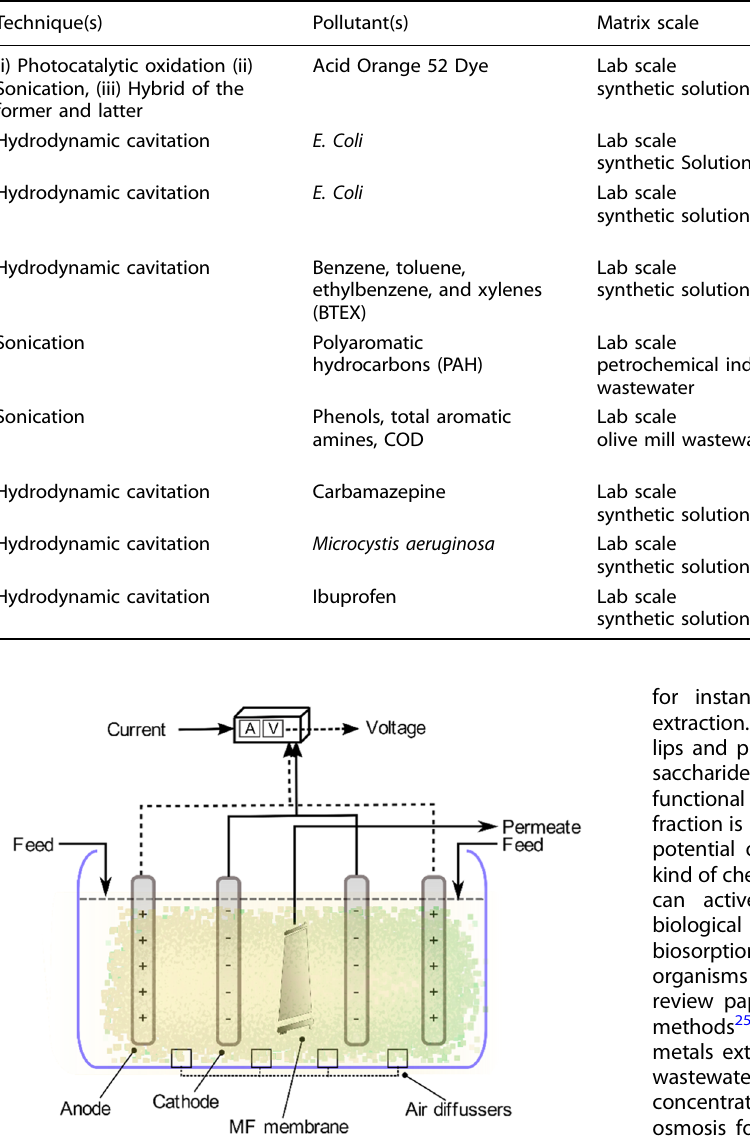
Fig. 5 Electrically-enhanced membrane bioreactor. An overview of an eMBR